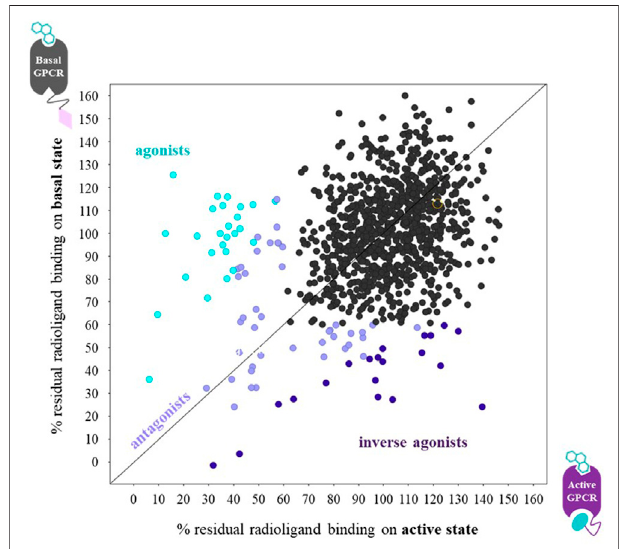
FIGURE 6 | Graph of the radioligand assay principle when performing parallel fragment screens on a ConfoBody-fused GPCR ( C = Cb80), representing its active state, and the same receptor fused to an irrelevant nanobody ( ◆ = irr VHH), representing its basal state conformation. Each data point measures the residual binding of the radiolabeled antagonist to the receptor. Agonists, antagonists, and inverse agonists differentially displace the radiolabeled antagonist. The ConfoBody-fused GPCR stabilizes a high- af fi nity agonist state, hence increasing the af fi nity for agonist-like fragments leading to a higher radioligand displacement on the active state conformation. Neutral antagonist fragments bind the basal and active state equally well (thus displace radioligand equally well independent of receptor conformer), while inverse agonists preferentially bind the basal state conformation, hence showing a higher radioligand displacement on the basal state conformation. Figure adapted from Pardon et al.